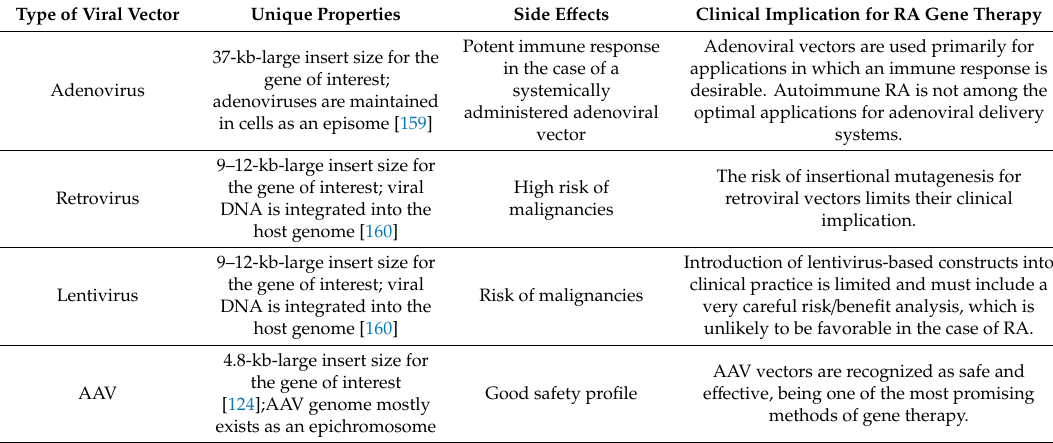
Table 2. Viral vectors for RA gene